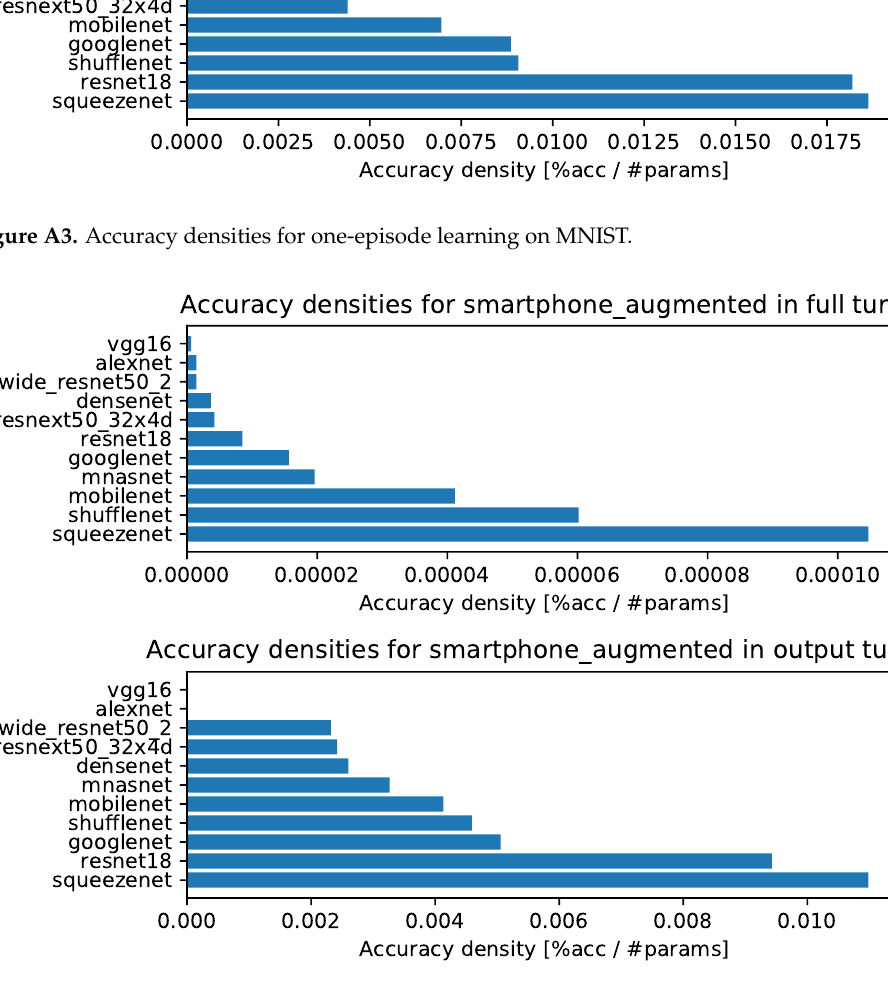
Figure A4. Accuracy densities for one-episode learning on augmented smartphone